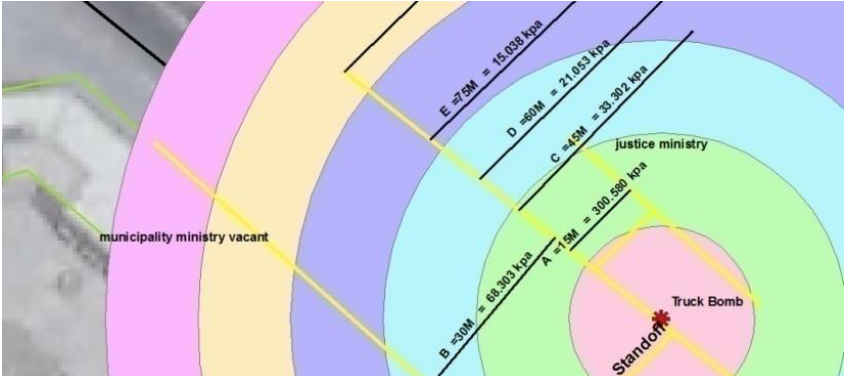
Fig. 14: Illustration, the blast wave pressure proportional inverse with standoff (distance from center of truck bomb to Initial blast wave pressure). Initial blast